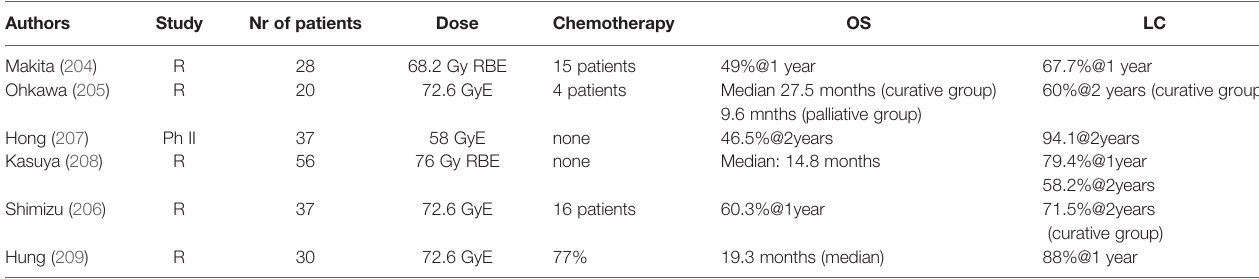
GyE, Gray equivalents; RBE, relative biological